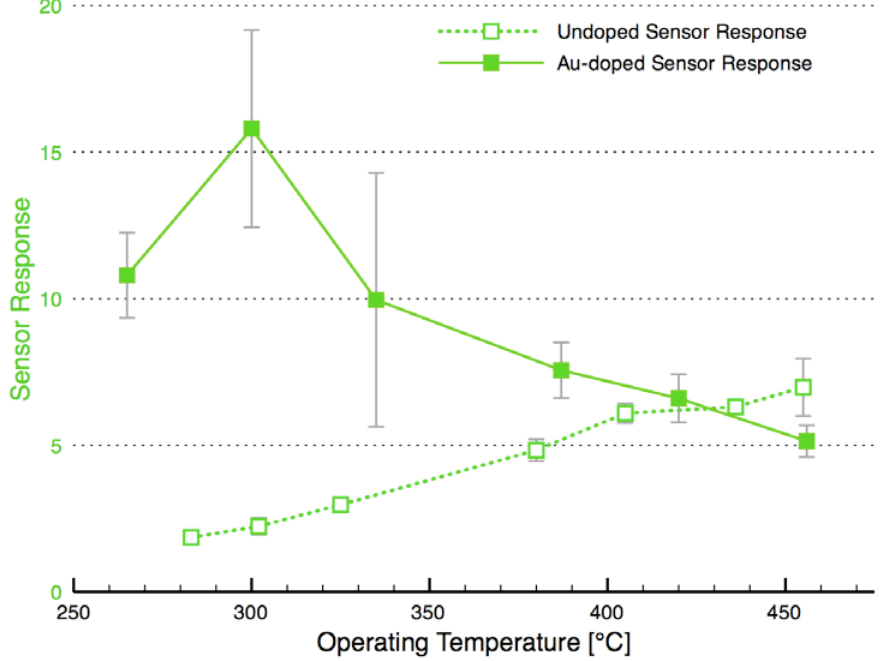
Figure 9. Comparison of the temperature dependence of Au-doped (Sensor D architecture) and undoped tin dioxide